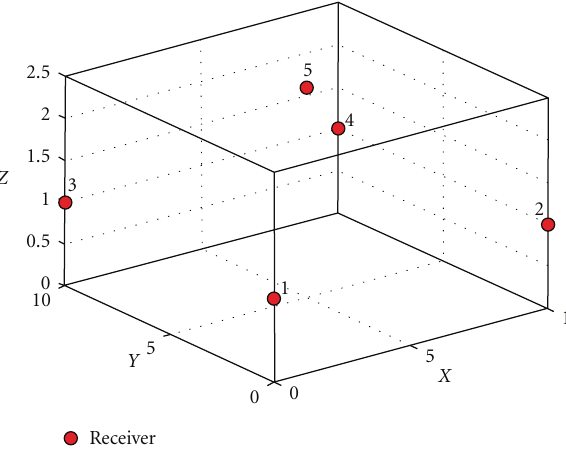
Figure 1: Scenario used for evaluation of localization